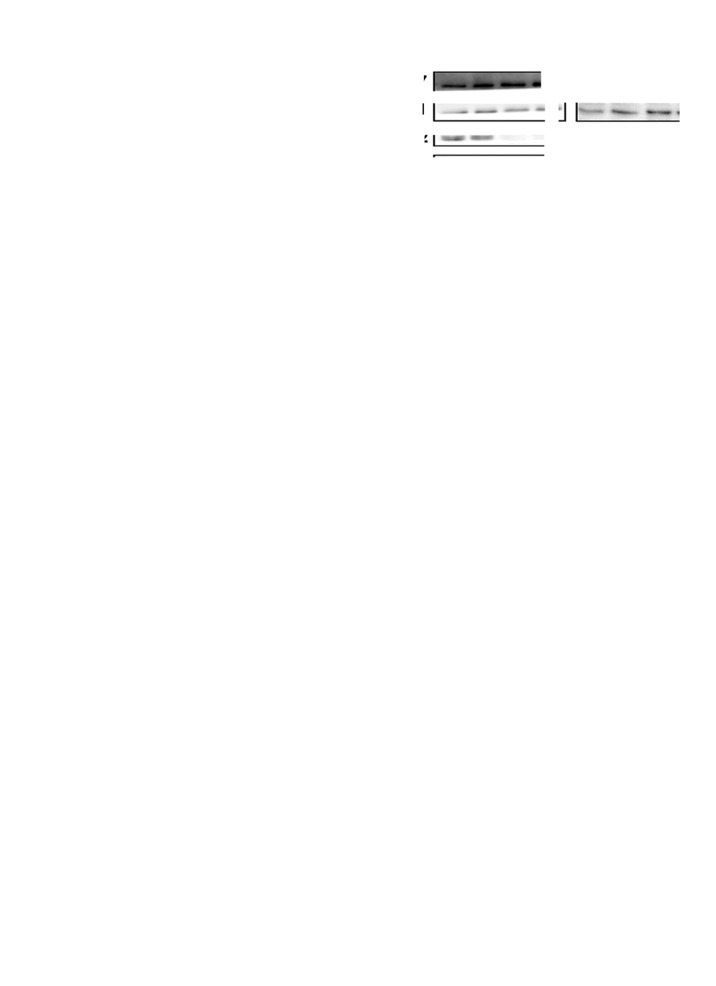
Glycyrrhetinic acid (GA) affects cell cycle regulatory proteins, E2F-1 and pRb. (A and B) Effect of GA on G1-phase regulatory cyclin-dependent kinase inhibitors (CKIs), cyclins, CDKs, E2F-1 and pRb assessed by western blot analysis in A549 and NCI-H460 cells treated with various concentrations of GA (12.5, 25 and 50 μmol/l) for 24 h. β-actin was used as a loading control. (C–H) Densitometry analysis of CKIs, cyclins, CDKs, E2F-1 and pRb levels relative to β-actin were performed using three independent experiments. Error bars represent SD; *p<0.01, #p<0.05. GA induces endoplasmic reticulum (ER) stress by activating Bip in both cell lines.